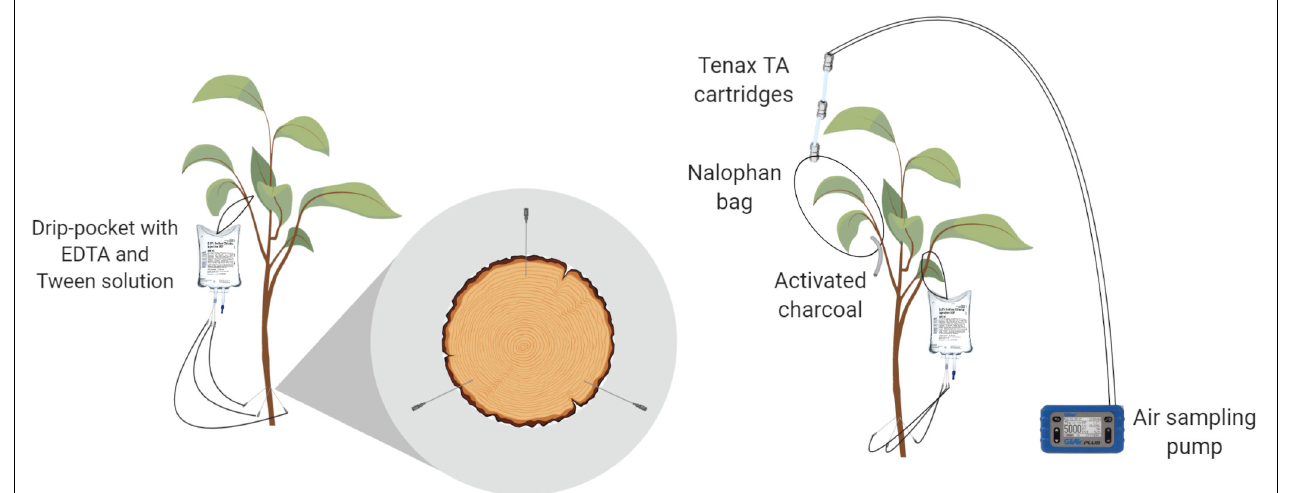
FIGURE 1 | Laboratory trunk-injection device (left) and sampling of leaf-emitted volatile organic compounds (VOCs) (right) .